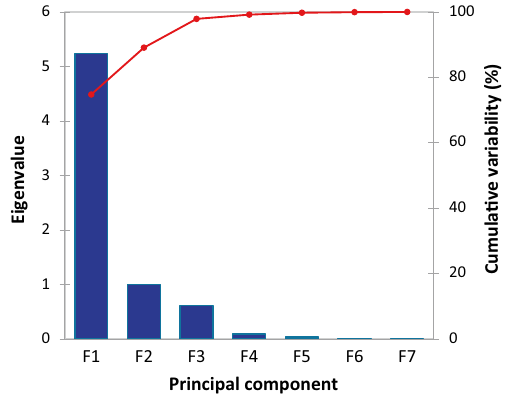
Fig. 11 Scree plot of the tested water